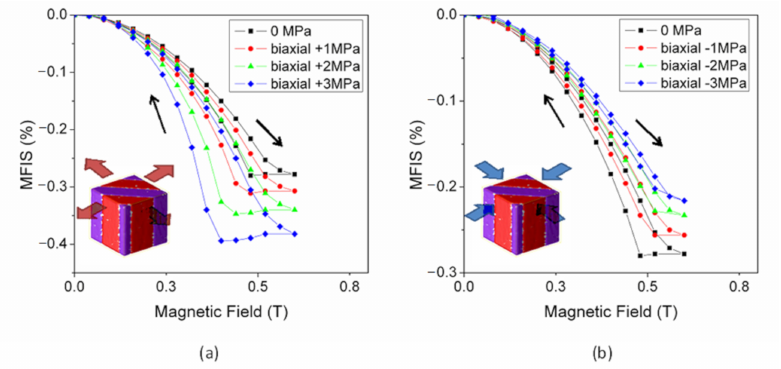
Figure 6. Simulated MFIS loops with different biaxial applied stress at 285 K: ( a ) biaxial tensile stress along y - and z -axis; ( b ) biaxial compressive stress along y - and z